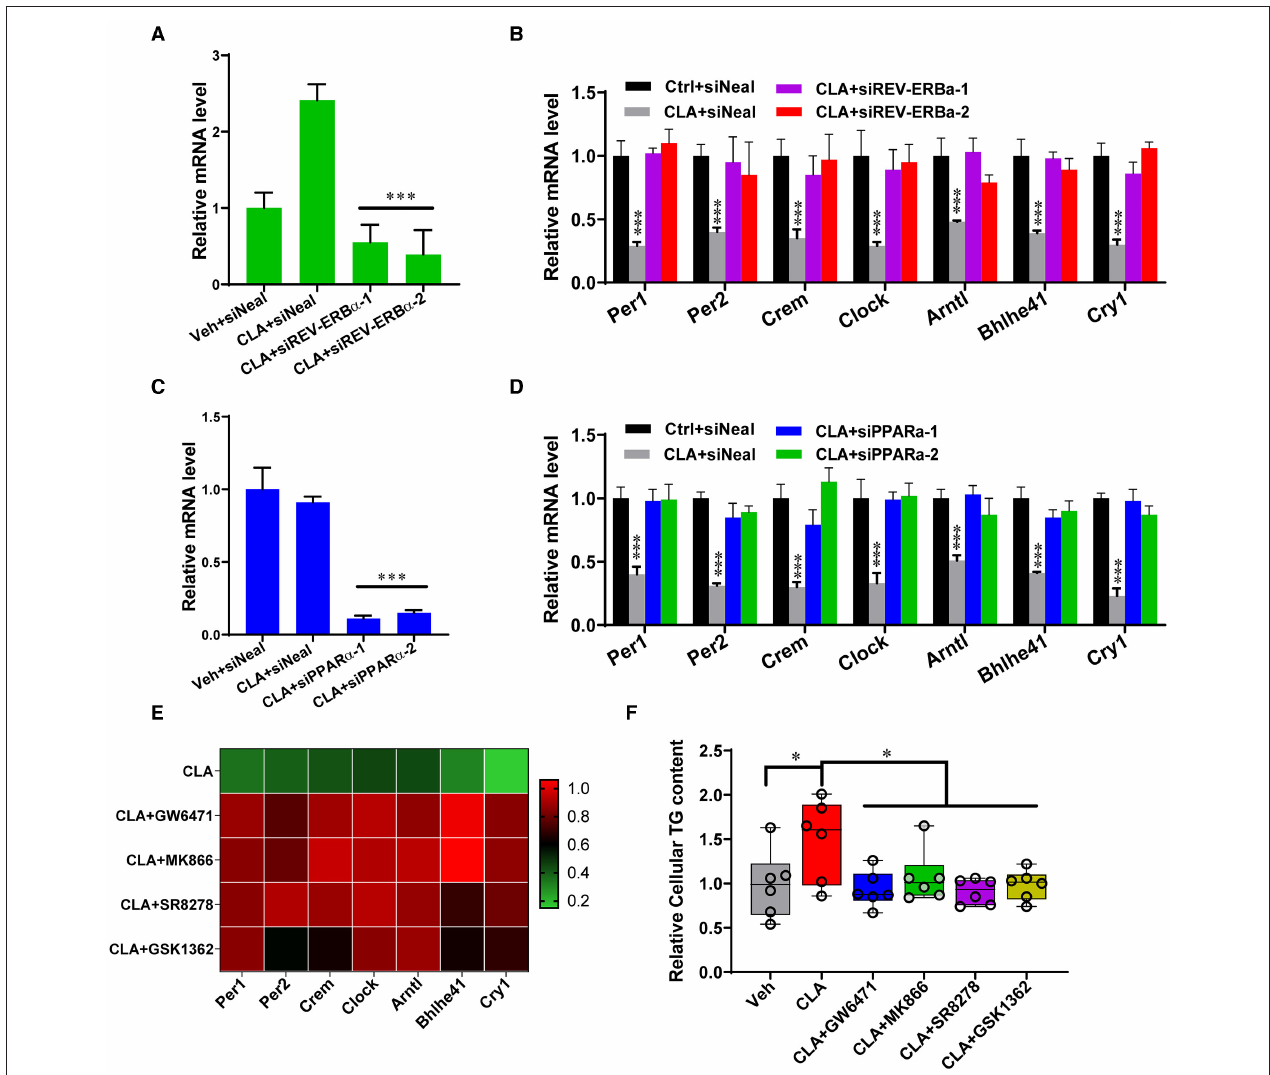
FIGURE 3 | REV-ERB α and PPAR α affect circadian genes transcription in the CLA-treated murine hepatocytes. (A,B) Relative mRNA levels of REV-ERB α or 7 key genes of the circadian clock (B) in Vehicle or CLA-treated mice derived primary hepatocytes treated with siREV-ERB α -1 and siREV-ERB α -2 or control vector. (C,D) Relative mRNA levels of PPAR α (C) or 7 key genes of the circadian clock (D) in hepatocytes treated with siPPAR α -1 and siPPAR α -2 or control vector. (E) Heatmaps of fold changes (in log2) of the circadian clock key genes mRNA analyzed by qRT-PCR in murine primary hepatocytes (10 µ M of antagonists, GW6471, MK866, SR8278, or GSK1362 treated for 24h compared to CLA with DMSO). (F) Relative total cellular triglyceride contents. The data are shown as the means ± SD, n = 6 per group. The experiments were repeated three times. * p < 0.05, *** p < 0.001, using ANOVA with Tukey’s post-hoc